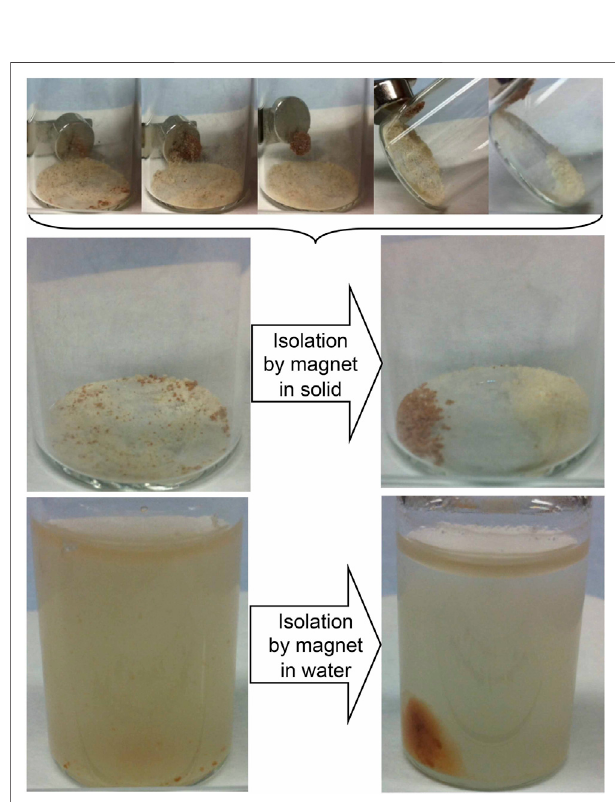
FIGURE 11 | Isolation of MS2 from empty bleached exines (BEIC) fi rstly using an external magnet in the dry (see top set of images, and the resultant separation, and subsequent Isolation of MS2 dispersed in water) again using an external magnet fi eld.